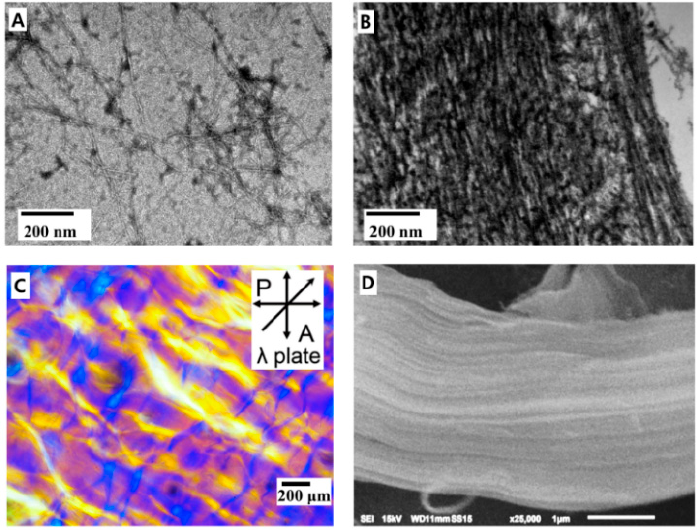
Figure 2. Morphological change of carboxylated cellulose nanofibers (CCNF) by conjugating catechol and silver nanoparticles. ( A ) TEM images of CCNF and ( B ) CCNF-DA/AgNPs; ( C ) polarized optical microscopy (POM) image of CCNF-DA with retardation ( λ ) plate; magenta and blue (or yellow) show disordered and anisotropic domains, respectively. The insect in ( C ) indicates the polarization directions of the polarizer (P) and analyzer (A); ( D ) SEM image of CCNF-DA.